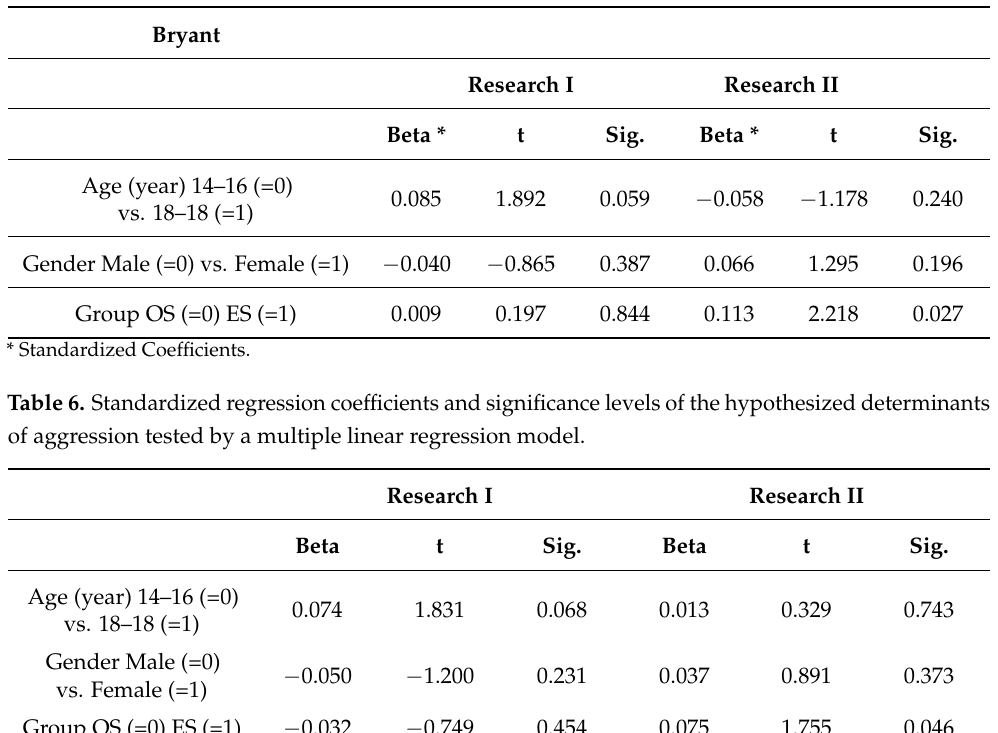
Table 5. Standardized regression coefficients and significance levels of the factors and independent variables estimated to influence aggression susceptibility based on a multiple linear regression model.